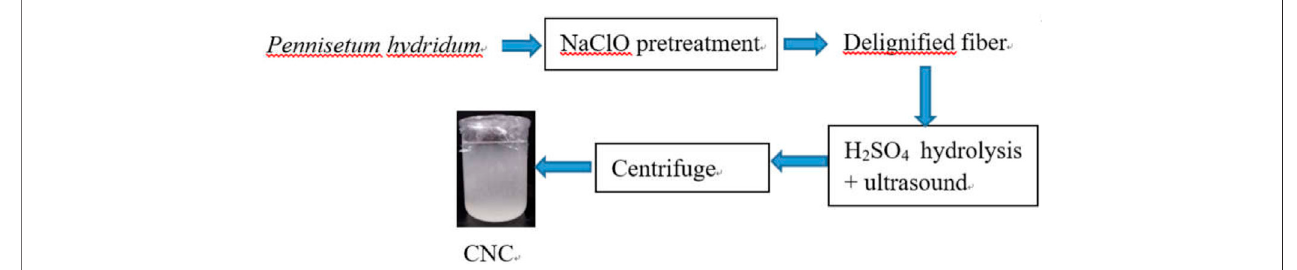
FIGURE 1 | Flowchart of CNC production.